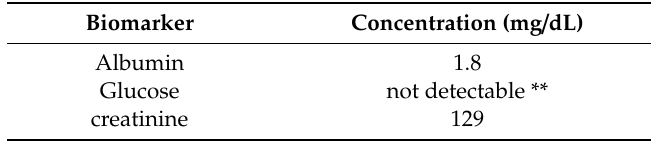
Table 2. The determination of albumin, glucose, and creatinine in a urine sample